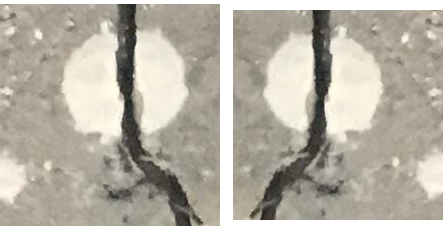
Figure 6. Example of Random Horizontal Flip transformation. (Left is the original